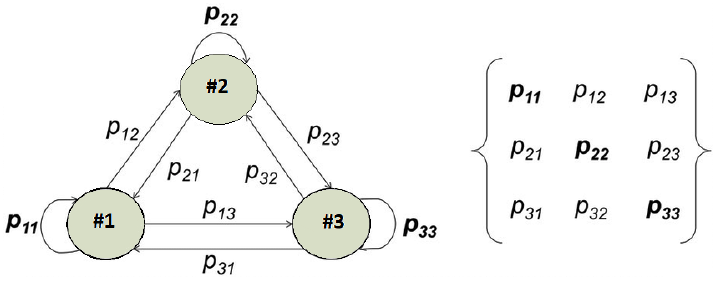
Figure 4. Three-state Markov channel